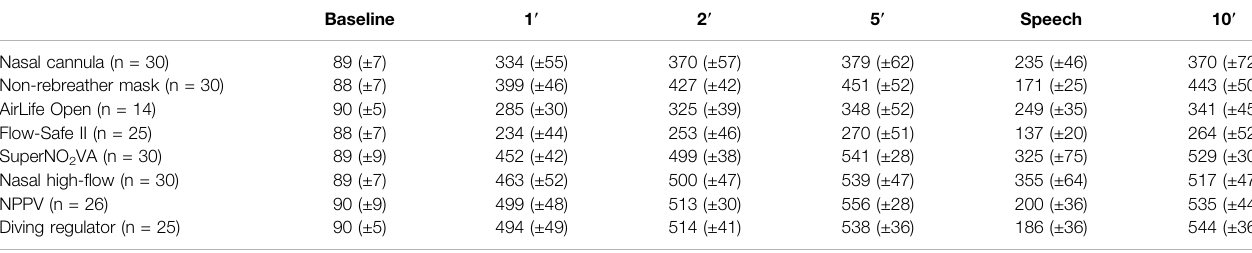
TABLE 1 | Mean arterial pO2 (mm Hg) achieved with the different oxygen systems (mean and standard deviation).